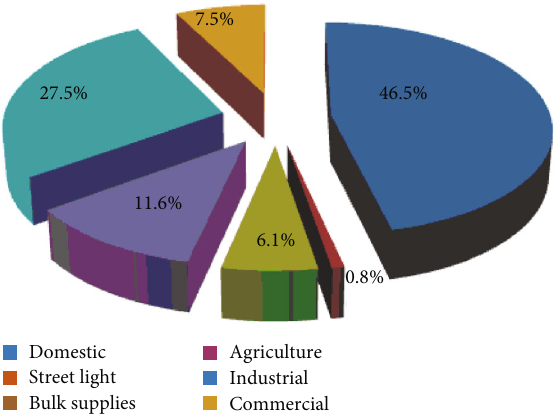
Figure 4: Sector-wise electricity consumption